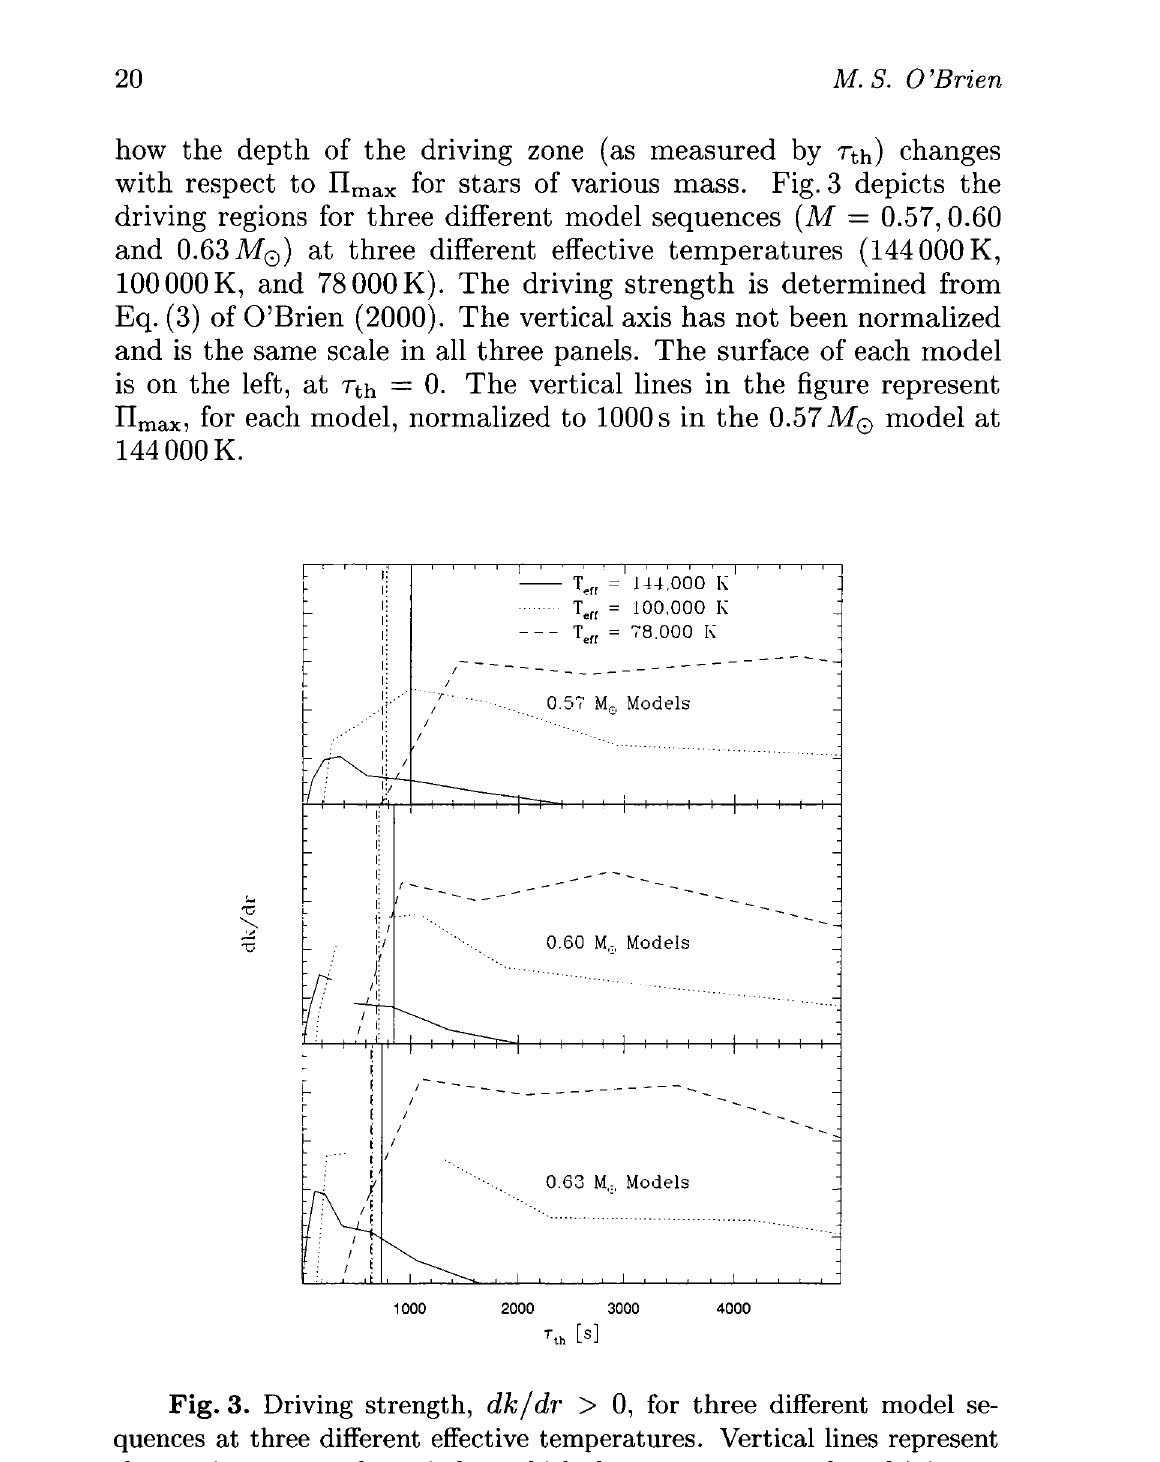
Fig. 3. Driving strength, dk/dr > 0, for three different model se- quences at three different effective temperatures. Vertical lines represent the maximum (/-mode period at which the star can respond to